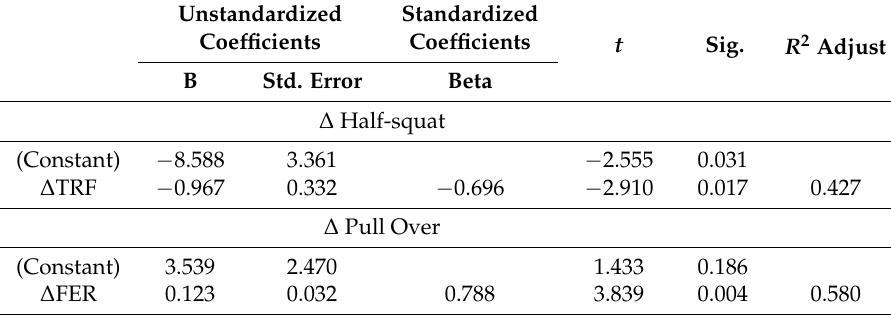
Table 2. Regression multivariate analysis with strength tests as the dependent